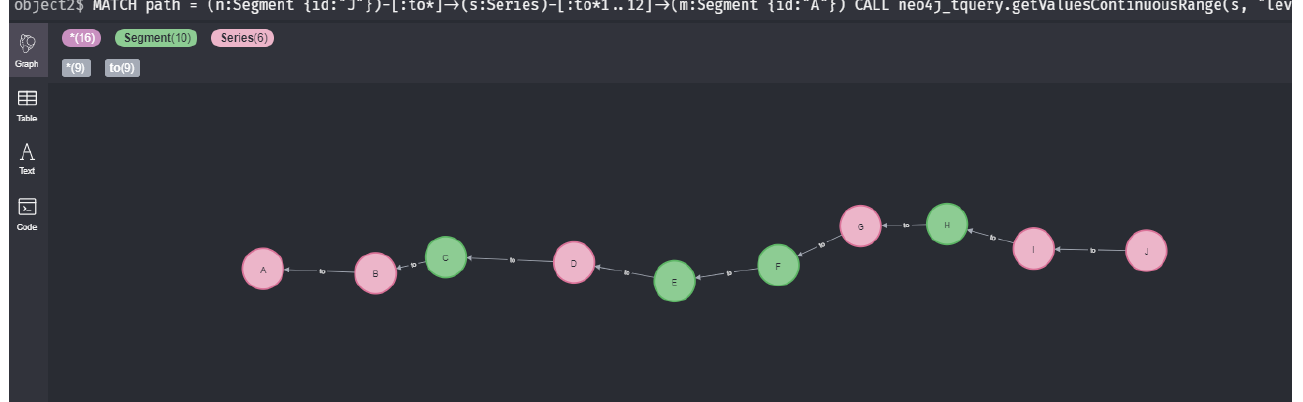
Figure 14. Visualization of the output of query Q 10 run on the network, visualized in Figure 4. The result is taken from the web interface Neo4j. All nodes correspond to river segments, and the segments equipped with a sensor are indicated in pink. In this case, there is only one path but the query would return multiple if they